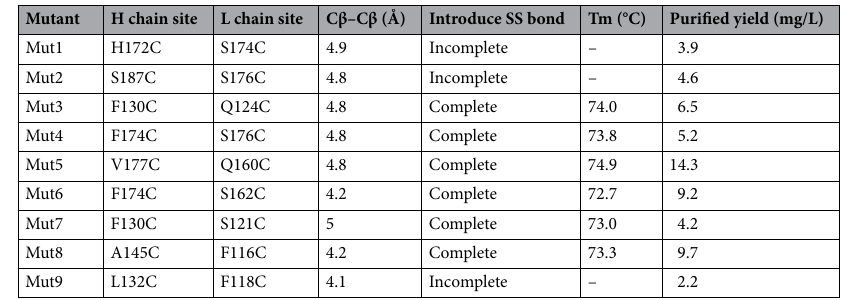
Table 1. Intermolecular SS mutants.